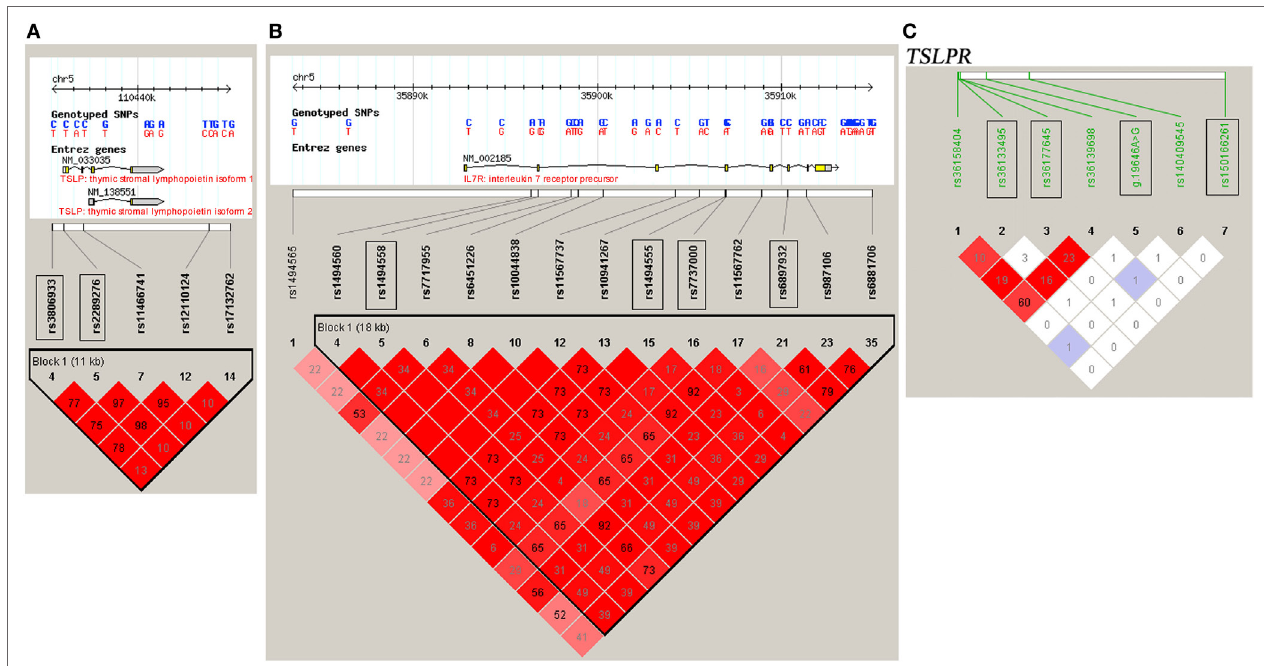
FigUre 1 | Linkage disequilibrium (LD) blocks of thymic stromal lymphopoietin ( TSLP ) and interleukin 7 receptor ( IL7R ) and TSLP receptor ( TSLPR ) . The LD blocks of (a) TSLP and (B) IL7R were constructed based on the HapMap CHB and JPT datasets, and the LD blocks of (c) TSLPR were constructed based on the data obtained by direct DNA sequencing of all the exons, the 500 bp of the 5 ′ flanking region and the intron–exon junctions of the gene TSLPR in 50 coronary artery disease cases and 50 healthy controls. The selected tag SNPs were marked with rectangular boxes. Each diamond represents the LD degree between the SNPs. The color indicates the D ′ (a redder color represents a higher D ′ ) and the numbers within the diamonds are the r 2